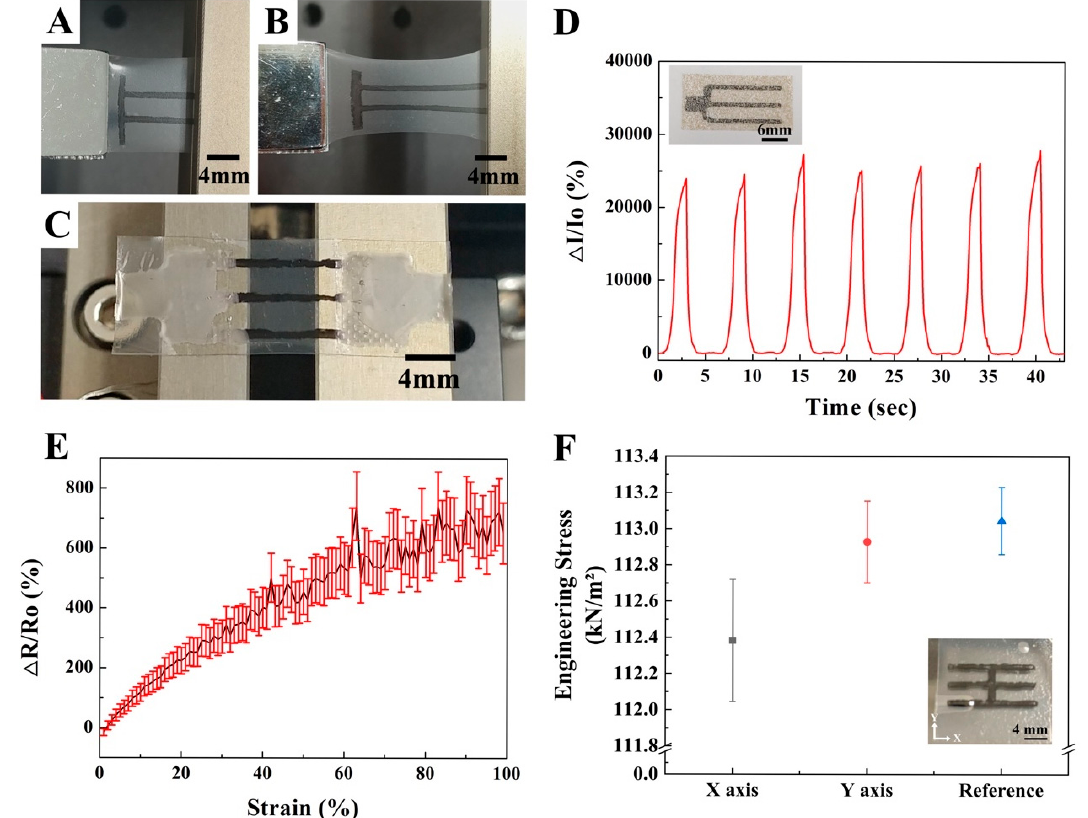
Figure 4. Electrical and mechanical properties of the encapsulated CNT double layer sensor. Images of the ‘ π ’ pattern when ( A ) 0% and ( B ) 100% strain were applied. ( C ) Double layer sensor with an Ag nanowire electrode on the CNT. ( D ) Time–current curves of CNT masked by polyimide film and measured by repeatedly stretching samples at 100% strain. ( E ) Changes in resistance when the sensor is stretched to 100%. ( F ) The average values and standard deviation of engineering stress of three CNT line patterns along the X ‐ axis, one along the Y ‐ axis and bare elastomer substrate (mixed by Ecoflex:PDMS = 5:1).